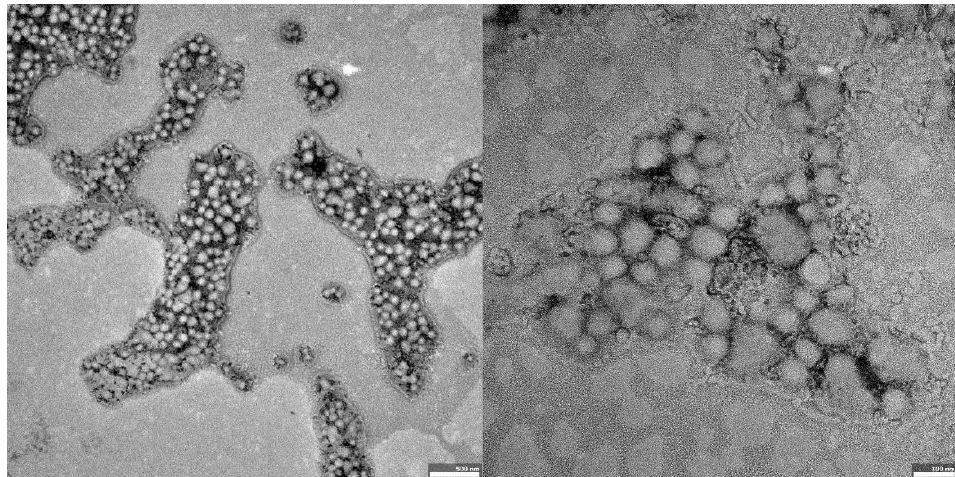
Figure 3. TEM images of UA-PLGA-PEG 2000 nanoparticles. Left panel : UA-PLGA-PEG 2000 magnitude 12 k, right panel : UA-PLGA-PEG 2000 Magnification: 50 k. Scale bar 500 nm ( left ), 100 nm ( right ).